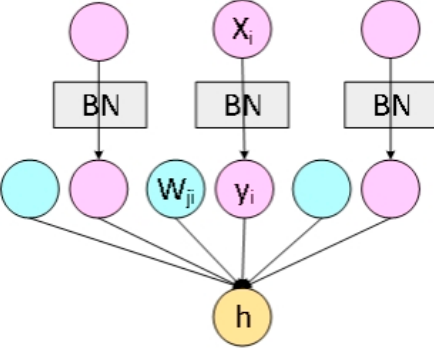
Figure 8. The structure of Batch Normalization.